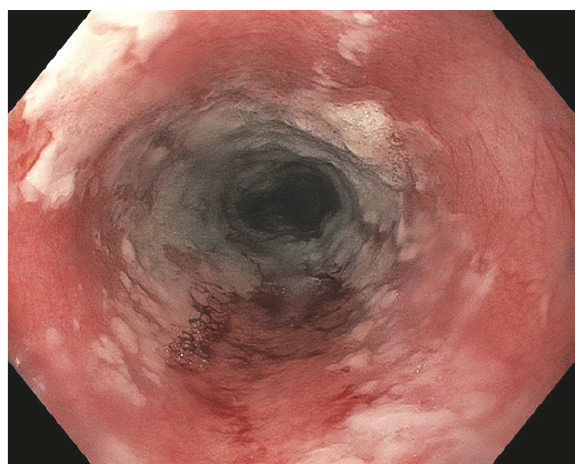
Figure 2: Necrotic appearing mucosa of distal esophagus.